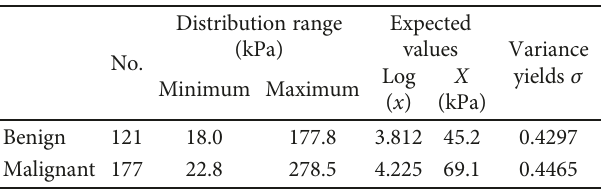
Figure 3: Statistical analysis curve of E max . (a) Normal frequency distribution histogram on curve on E max of benign lesions. (c) Log-normal frequency distribution curve on E max of malignant lesions. (d) Probability density function curve and the expected values for benign and malignant nodules based on the logarithmic normal distribution. Table 5: Statistical results of E max in benign and malignant thyroid